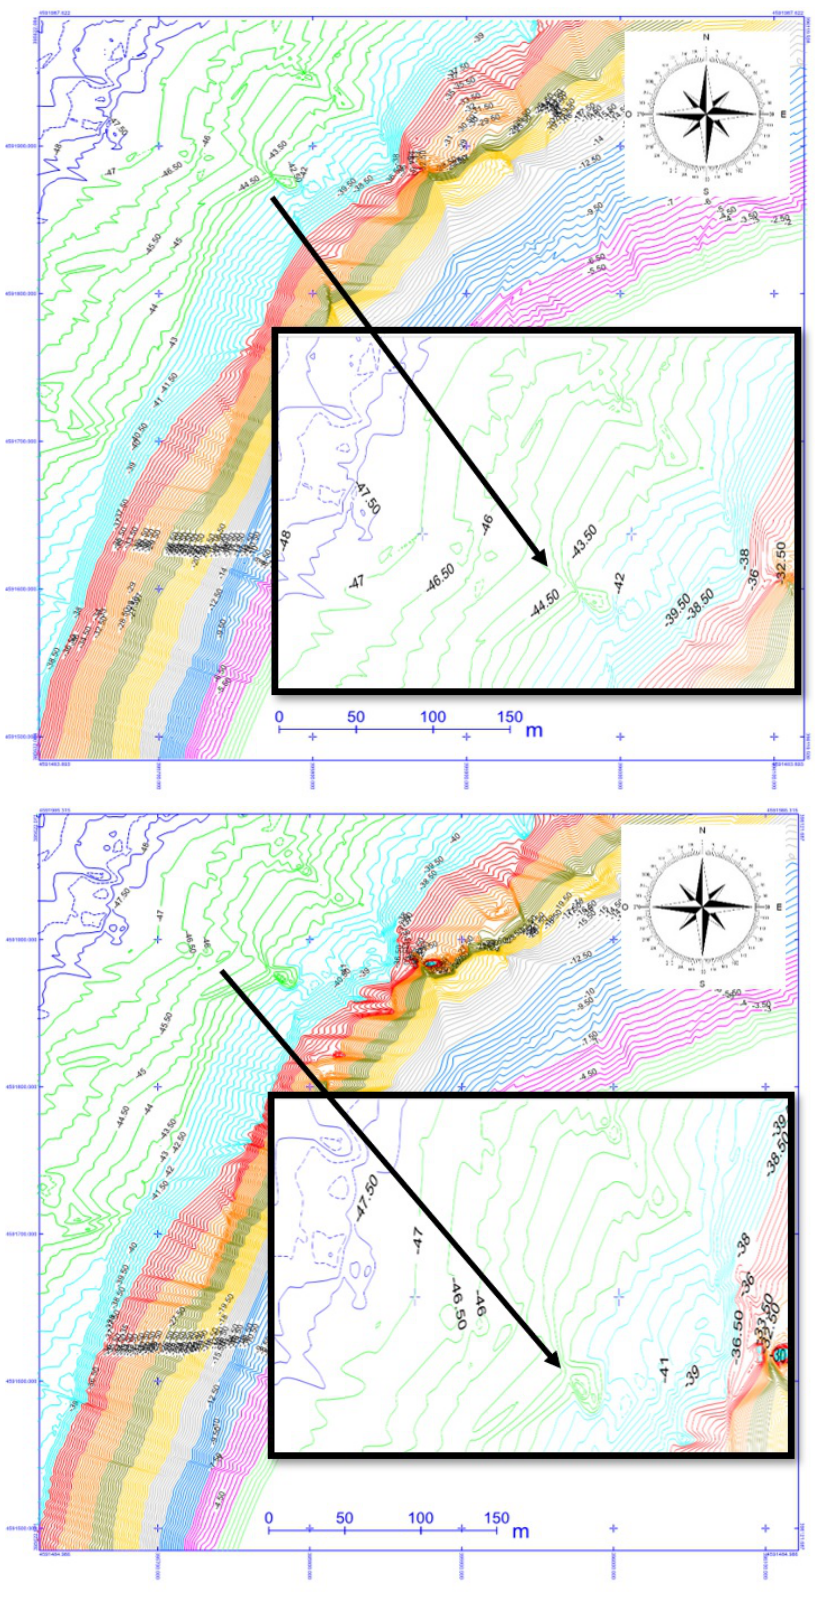
Figure 19. ( top ) Bottom topography model based on the measured map. ( bottom ) Corrected map model based on the slope of the bottom